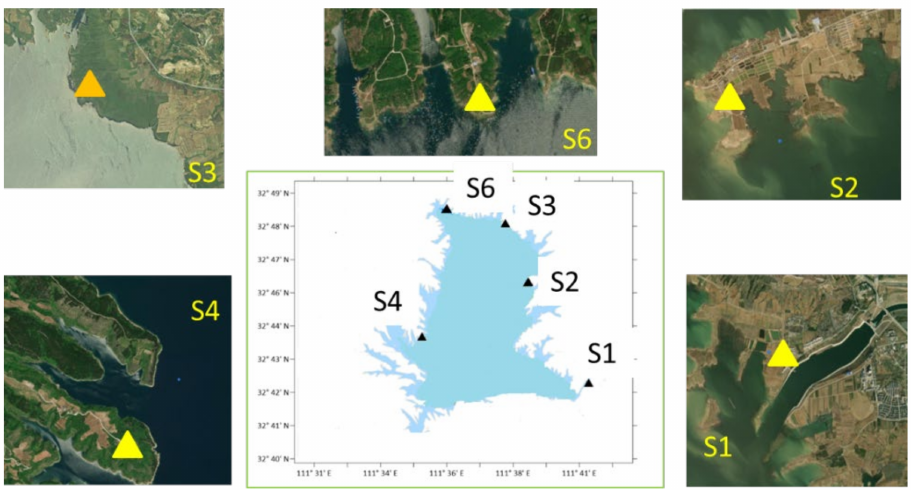
Figure 1. Sampling point position and automatic